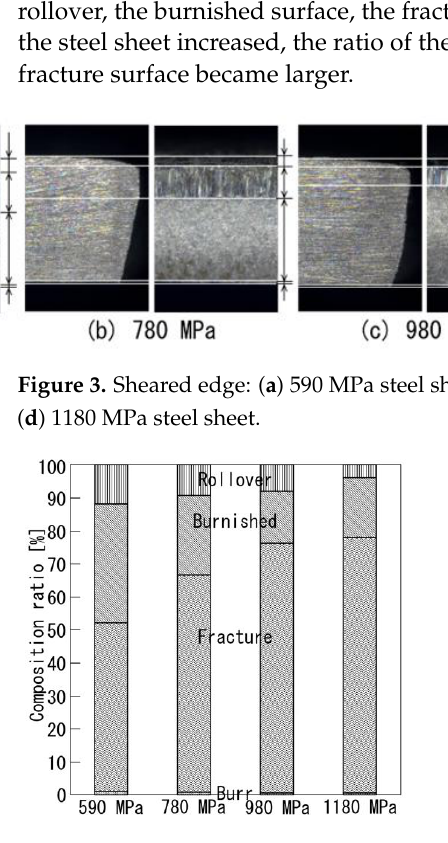
Figure 4. Quality of sheared edge of cut sheet.